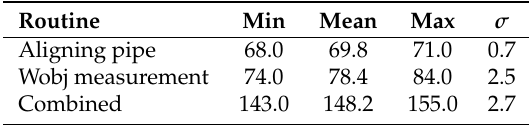
Table 2. Time, in seconds, needed to align the